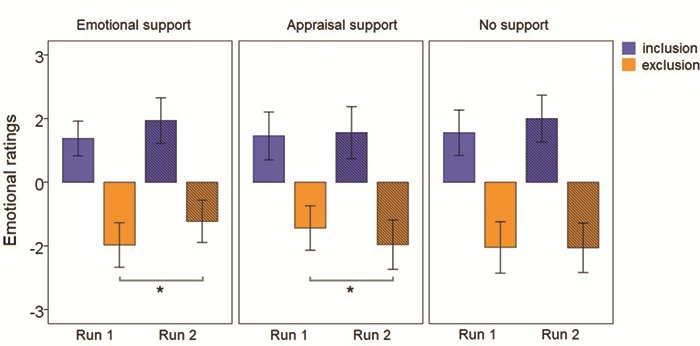

Behavioral results. Mean and confidence intervals (95%) divided by group, condition and run. Significant differences are marked with an asterisk (P < 0.05, based on post hoc pairwise comparisons)